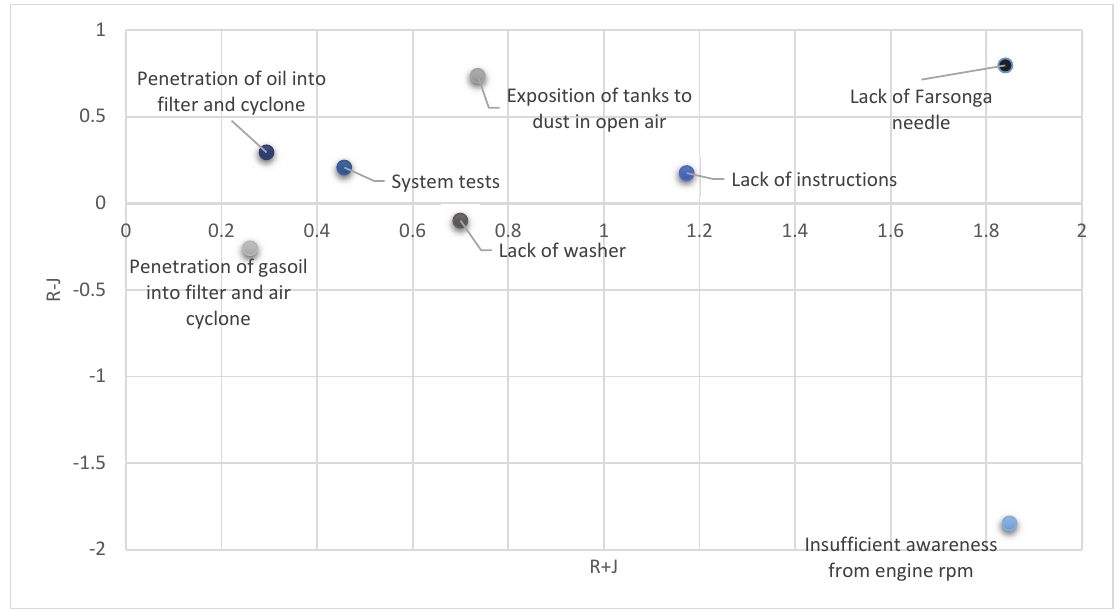
Fig.3. Influential network relation map (INRM) related to the root causes of "mixing oil &